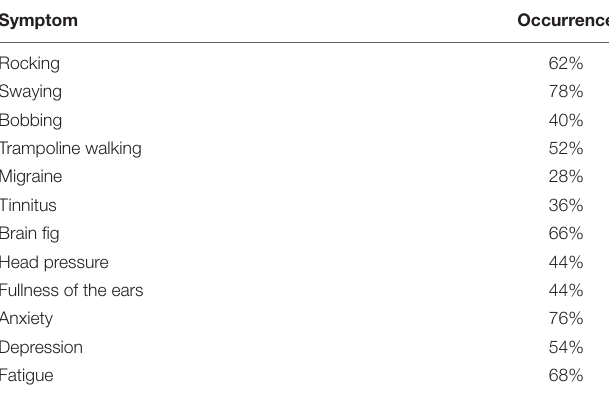
TABLE 1 | Symptoms reported by 50 MdDS patients with gravitational pull as the dominant sensation of motion. Symptom